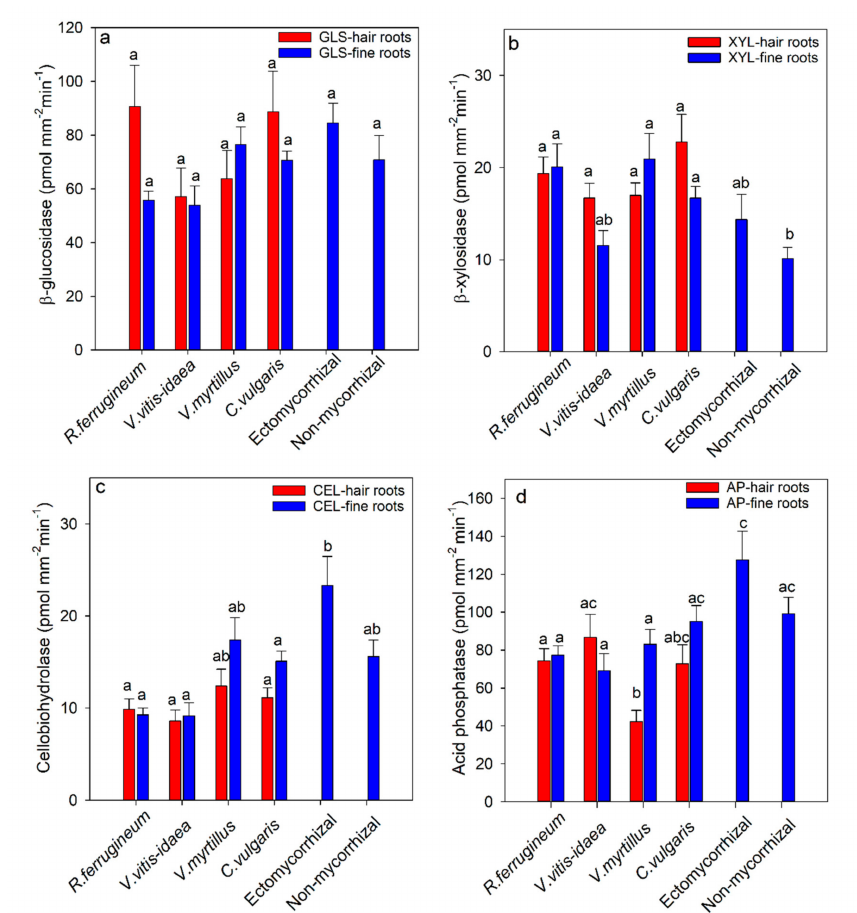
Figure 2. β -glucosidase ( a ), β -xylosidase ( b ), celliobiohydrolase ( c ), and acid phosphatase ( d ) activity of fine roots and hair roots of the ericaceous species ( Rhododendron ferrugineum , Vaccinium vitis idaea , Vaccinium myrtillus , Calluna vulgaris ) and ectomycorrhizal and non-mycorrhizal root tips of Picea abies at the tree line (1668 to 1791 m). The roots were collected at Wasserberg in the central Alps, Austria. Bars show means ± SE. Bars not followed by the same letters are significantly different ( p ≤ 0.05) among ericaceous species, ectomycorrhizal species, or non-mycorrhizal roots tips (ab). There were no significant differences between hair roots and fine roots for the same ericaceous species ( p ≤